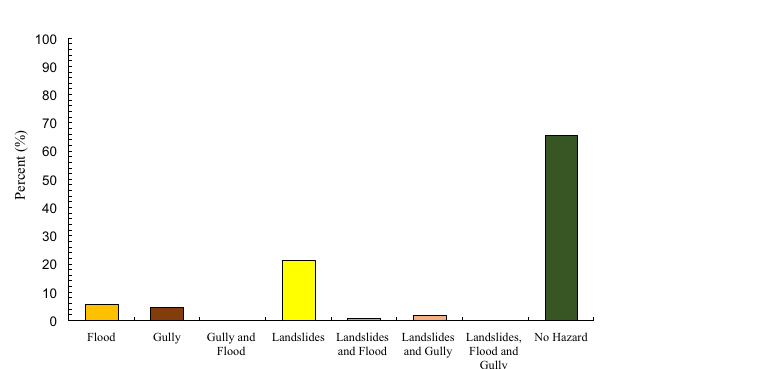
Figure 8. Multi-hazard probability map (MHPM).